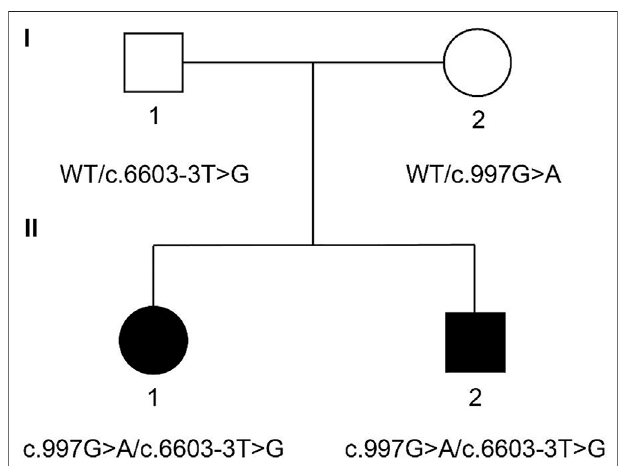
FIGURE 1 | Family pedigree of two probands. Probands II-1 and II-2 carry compound heterozygous mutation c.997 G > A (chr12:80862555) and c.6603-3 T > G (chr12:81066945) of PTPRQ. The mother of the probands carries heterozygous mutation c.997 G > A. The father of the probands carriesheterozygousmutationc.6603-3T > G.Probandsaremarkedinblack. WT, wild